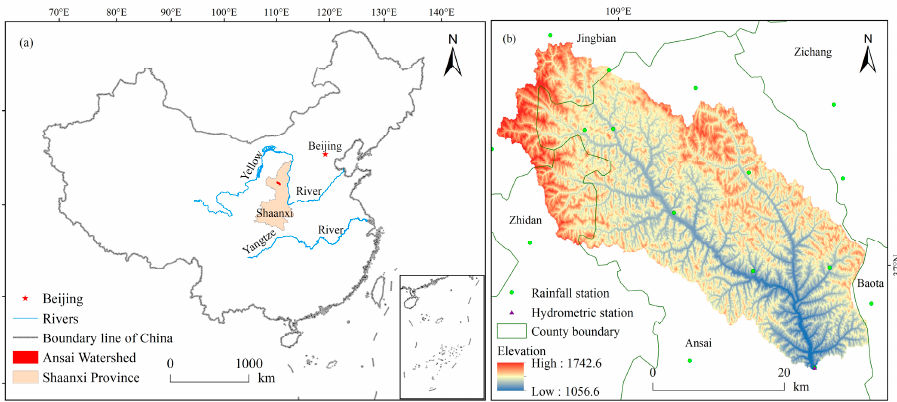
Figure 1. The study area: ( a ) The geographical location of the Ansai Watershed; ( b ) The elevation, rainfall and hydrometric stations distribution in the Ansai Watershed.